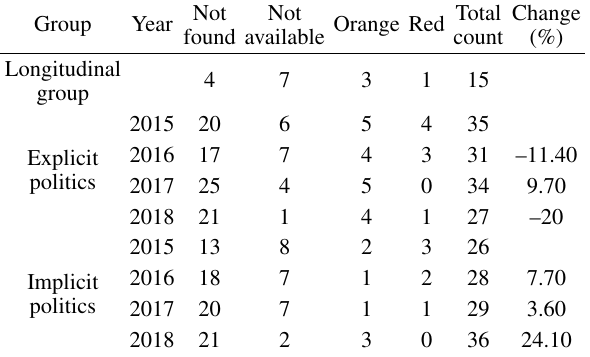
Table 2 Botometer results: Relevant counts. Total Change Not Not Orange Red Group Year count (%) found available